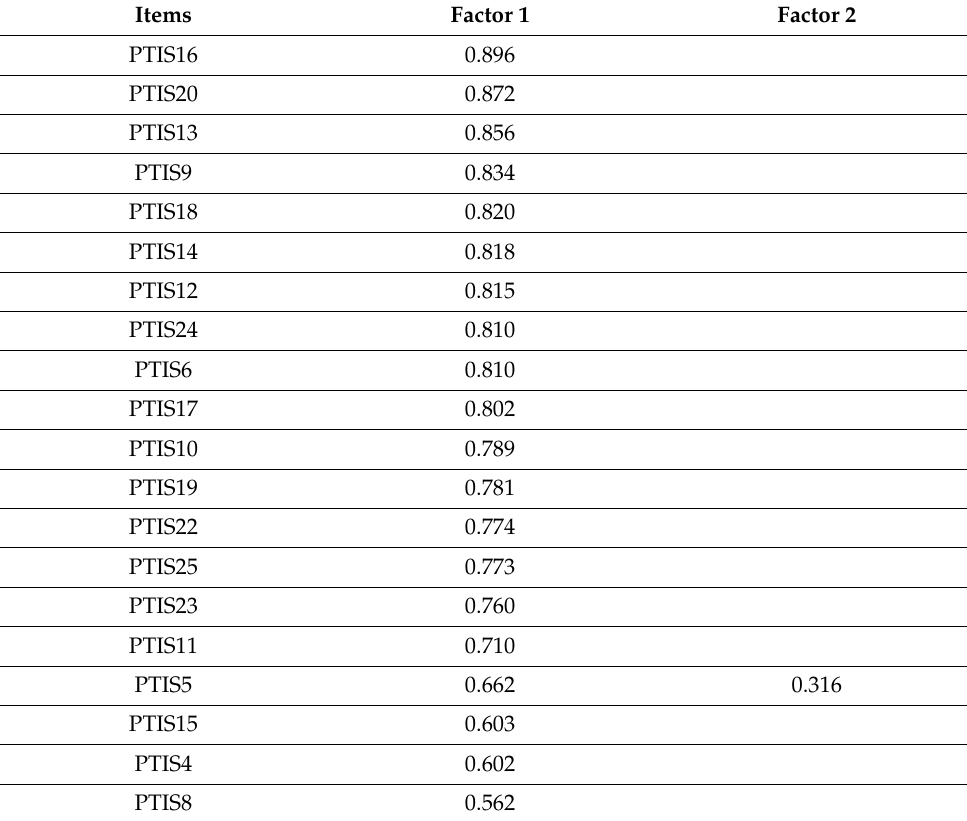
Table 1. Results of the Exploratory Factor